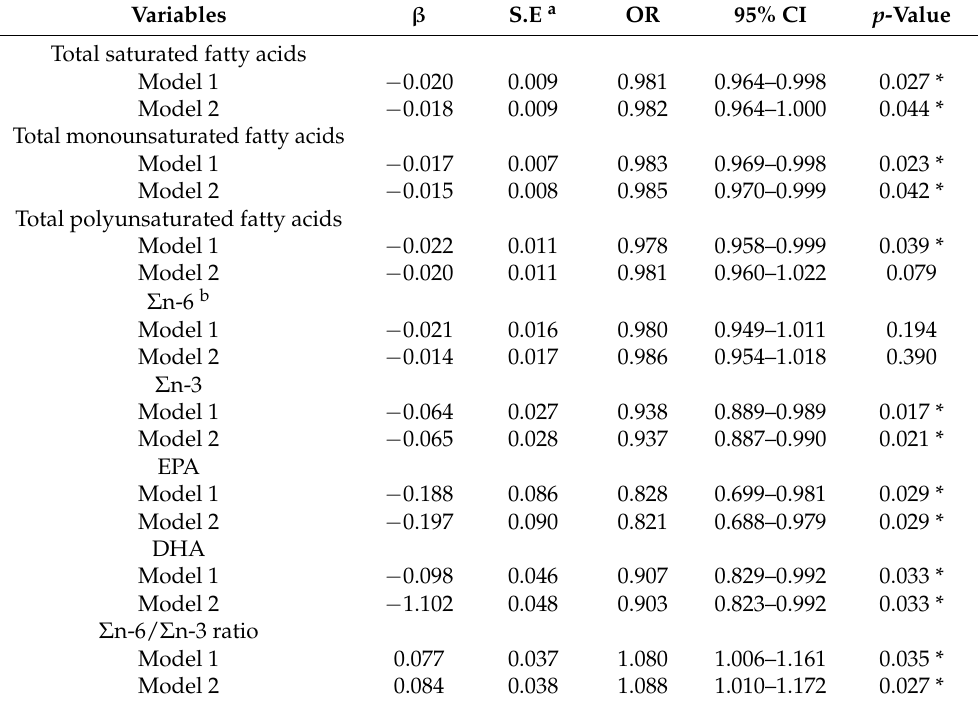
Table 5. Associations between dietary fatty acids and diabetic